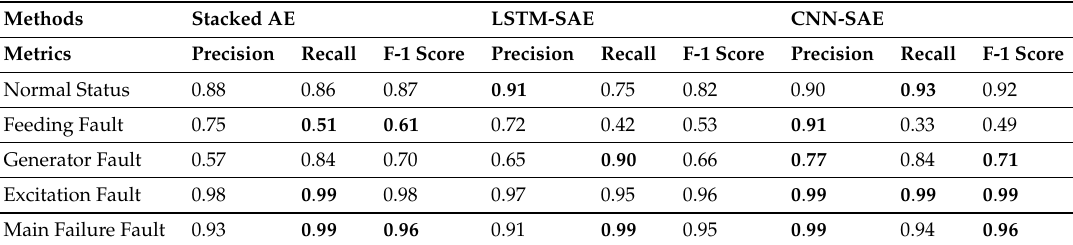
Table 6. Quantitative evaluation of the developed